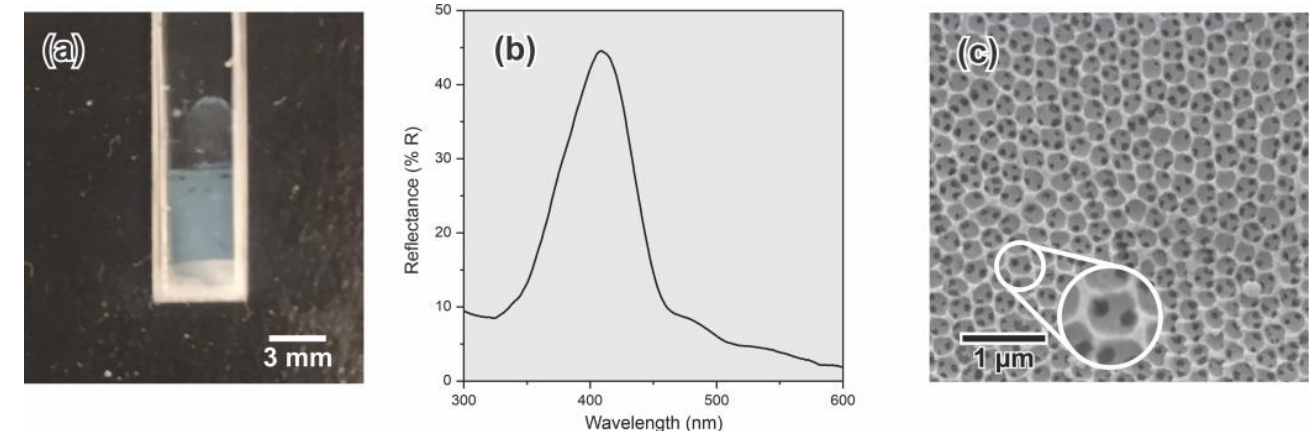
Figure 10. IO polymeric film: optical image ( a ), reflectance spectra ( b ), and SEM micrograph ( c ).